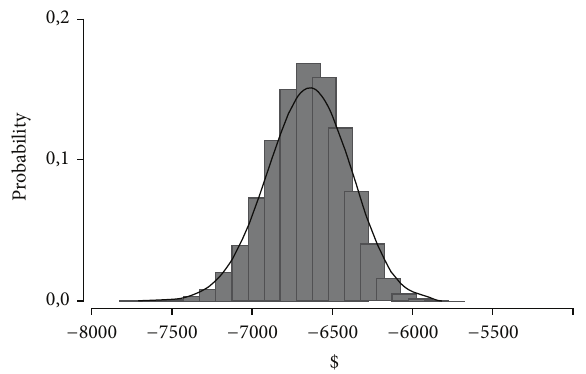
Figure 6: Probabilistic sensitivity analysis of ICER distribution of CERA versus EpoB. The analysis confirmed the robustness of the model, based on 50000 random iteration; the ICER remain within the range of calculated ICER ±